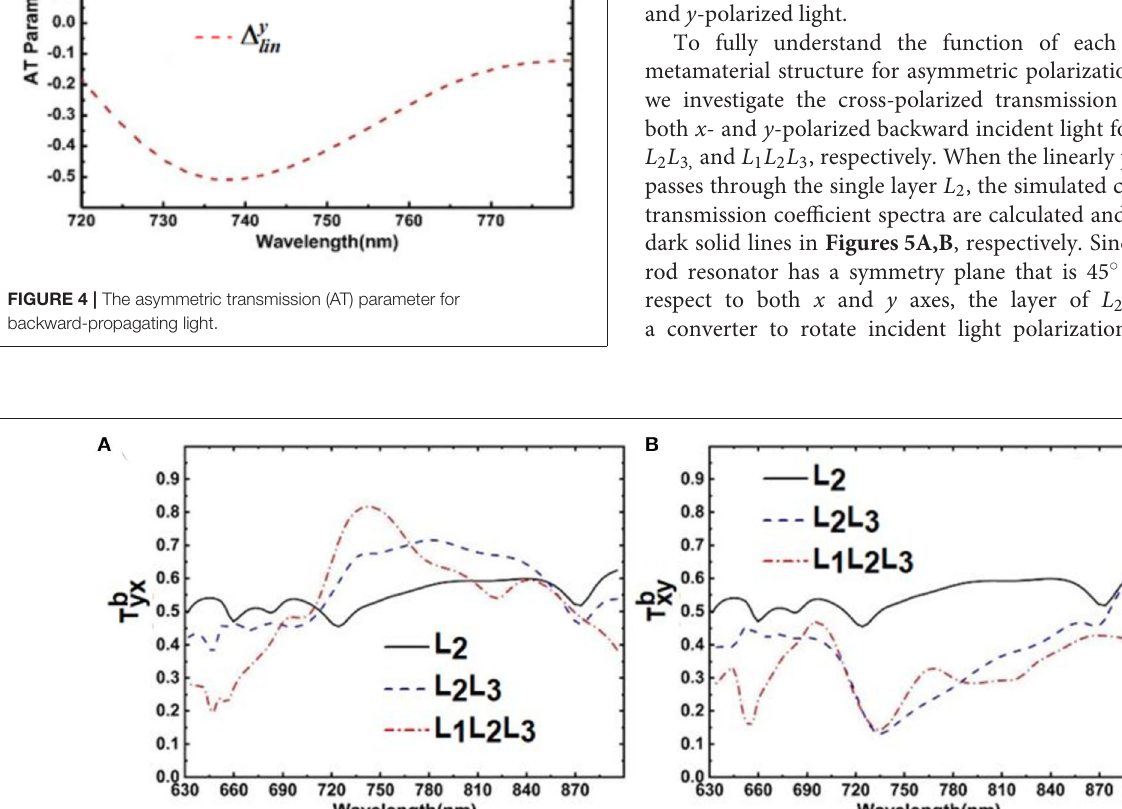
Frontiers in Physics |